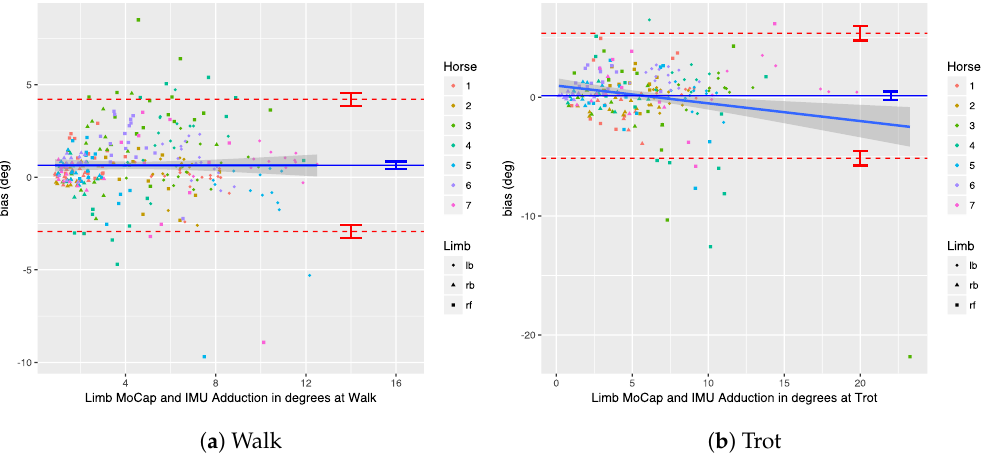
Figure 22. Bland–Altman analysis for adduction angles at walk and trot.